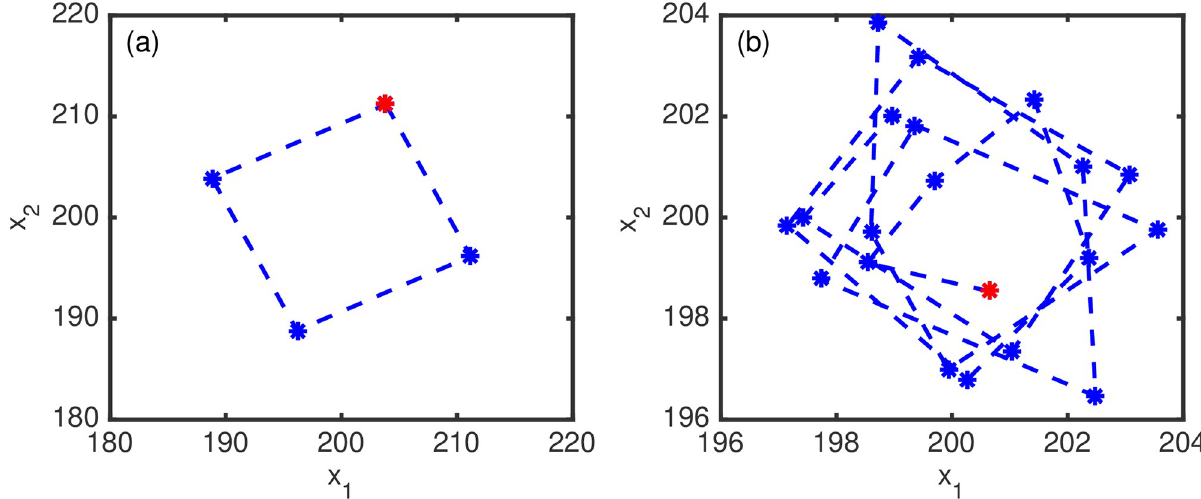
Fig 1. Experiment 1. The modelled phase plane of the background solution (a) and the truth solution (b). The initial conditions are given by the red dot and the solution points are in blue.